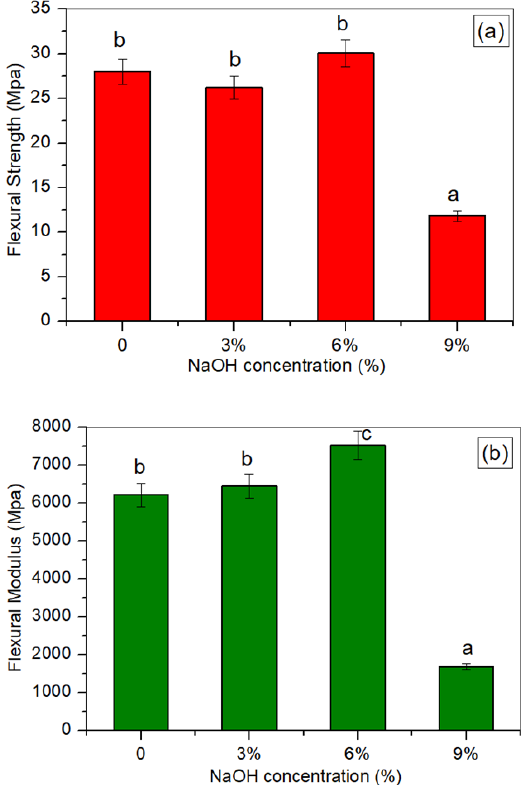
Figure 4. The ( a ) flexural strength, and ( b ) flexural modulus of untreated and treated TPCS/PW/CCF composites at different NaOH concentrations. Letters a, b, and c is indicates the group of data for statistical